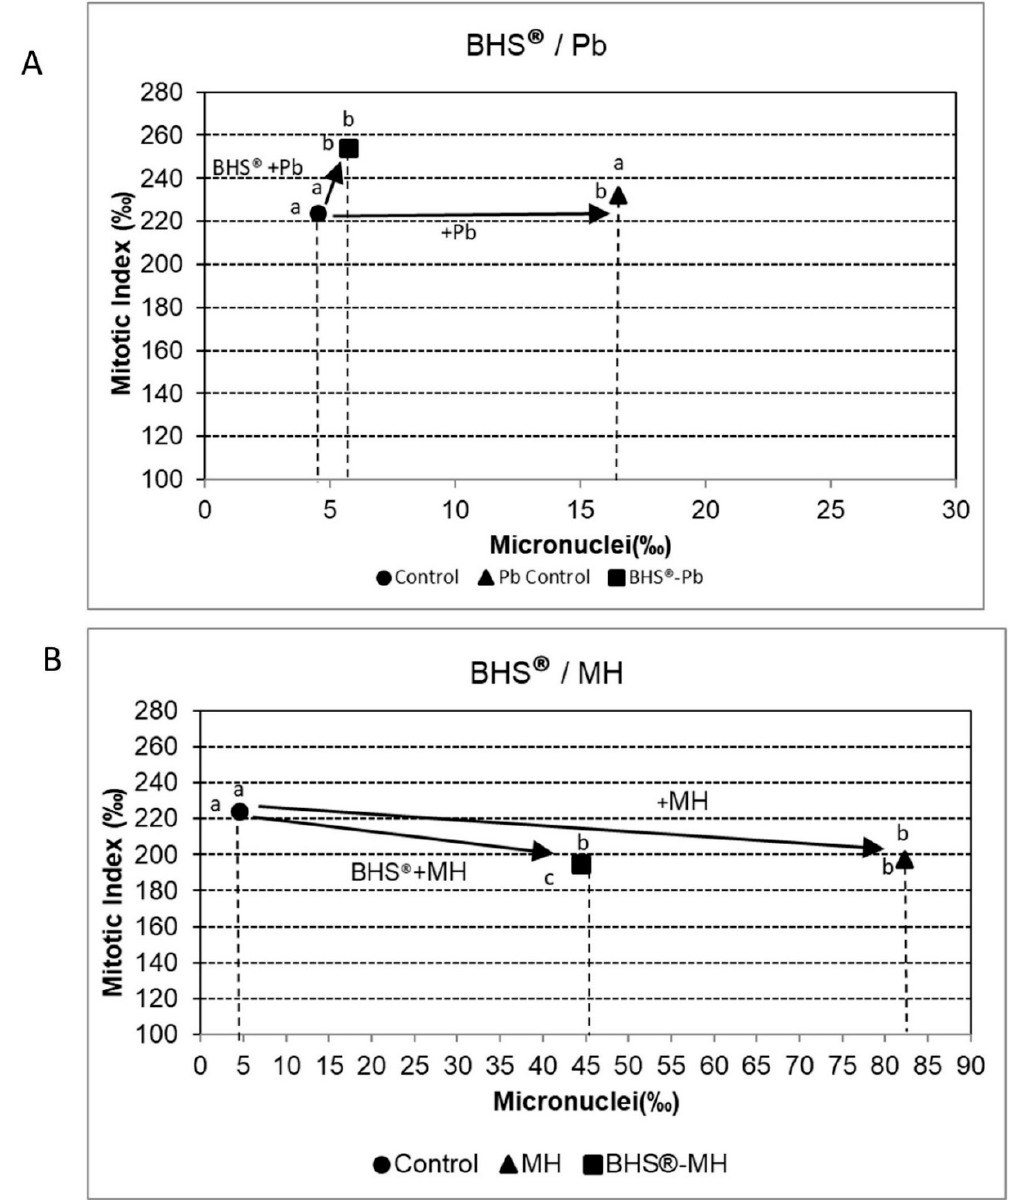
Figure 6. ( A , B ): Variation of micronuclei as a function of the mitotic index for plantlets of Vicia faba exposed to ( A ) 1 mg.L − 1 lead nitrate (Pb) or to ( B ) 10 − 5 M maleic hydrazine (MH) or with or without pretreatment by biomimetic humic substances (BHS ® ) (letters on the left of the data symbol points correspond to statistical analysis of the micronuclei frequency. Letters above the symbol data correspond to statistical analysis of the mitotic index. Data marked with the same letter are not statistically different at p < 0.05).